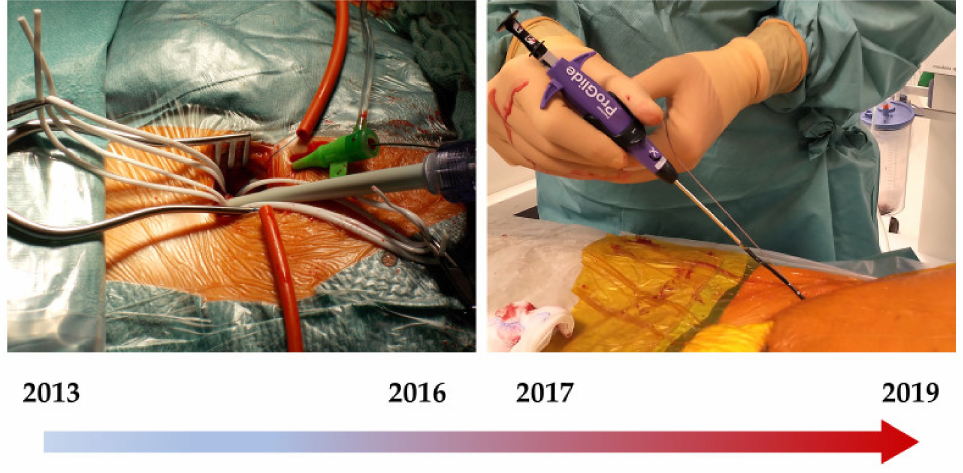
Figure 1. Surgical und ProGlide access over time (intraprocedural